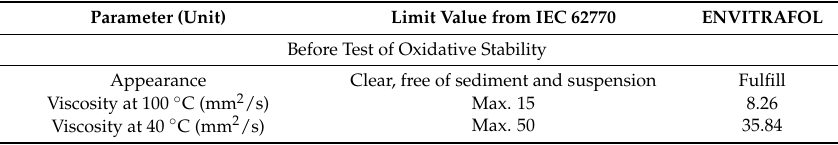
Table 5. Comparison of the characteristic parameters of the ENVITRAFOL with the limit values according to IEC